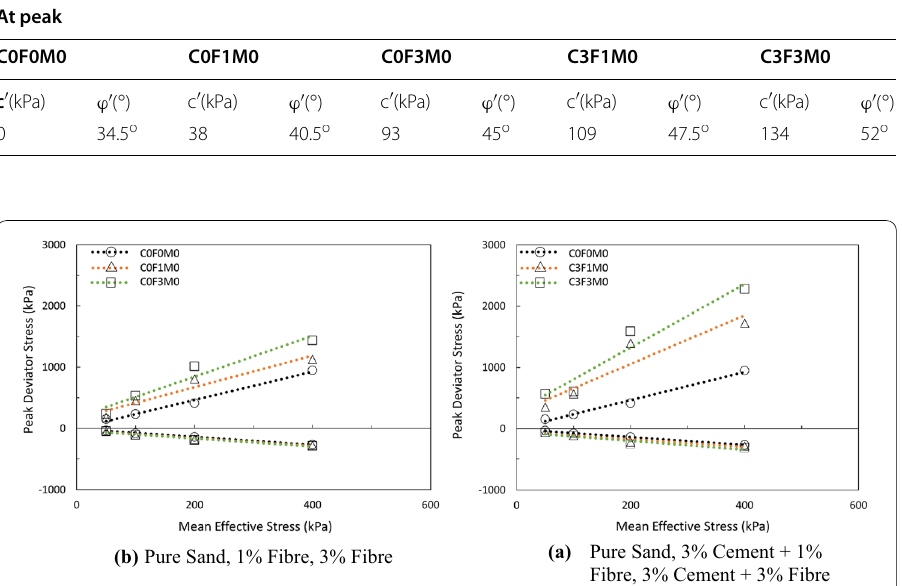
Fig. 9 Strength envelopes from CID compression and extension tests for unreinforced, fibre, and fibre reinforced cemented Toyoura sand specimens consolidated to varying mean effective stresses a Pure sand, 3% cement 1% fibre, 3% cement 3% fibre b Pure sand, 1% fibre, 3% + +